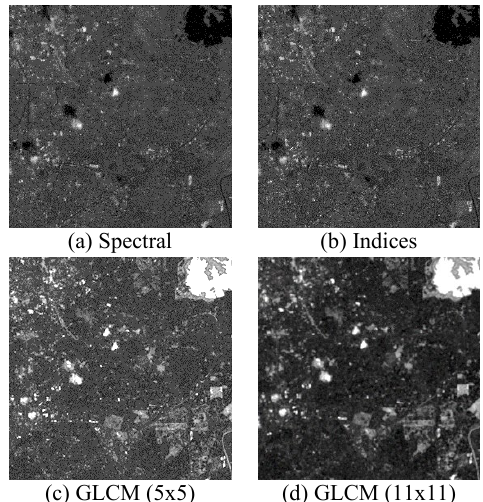
Figure 6. Single-band gray renders of the first principal component bands extracted using (a) Spectral bands, (b) Indices derived from the Spectral band, (c) GLCM (5x5) layers, and (d) GLCM (11x11) layers. Figure 8. Original and sieved outputs (Level 1 best output)